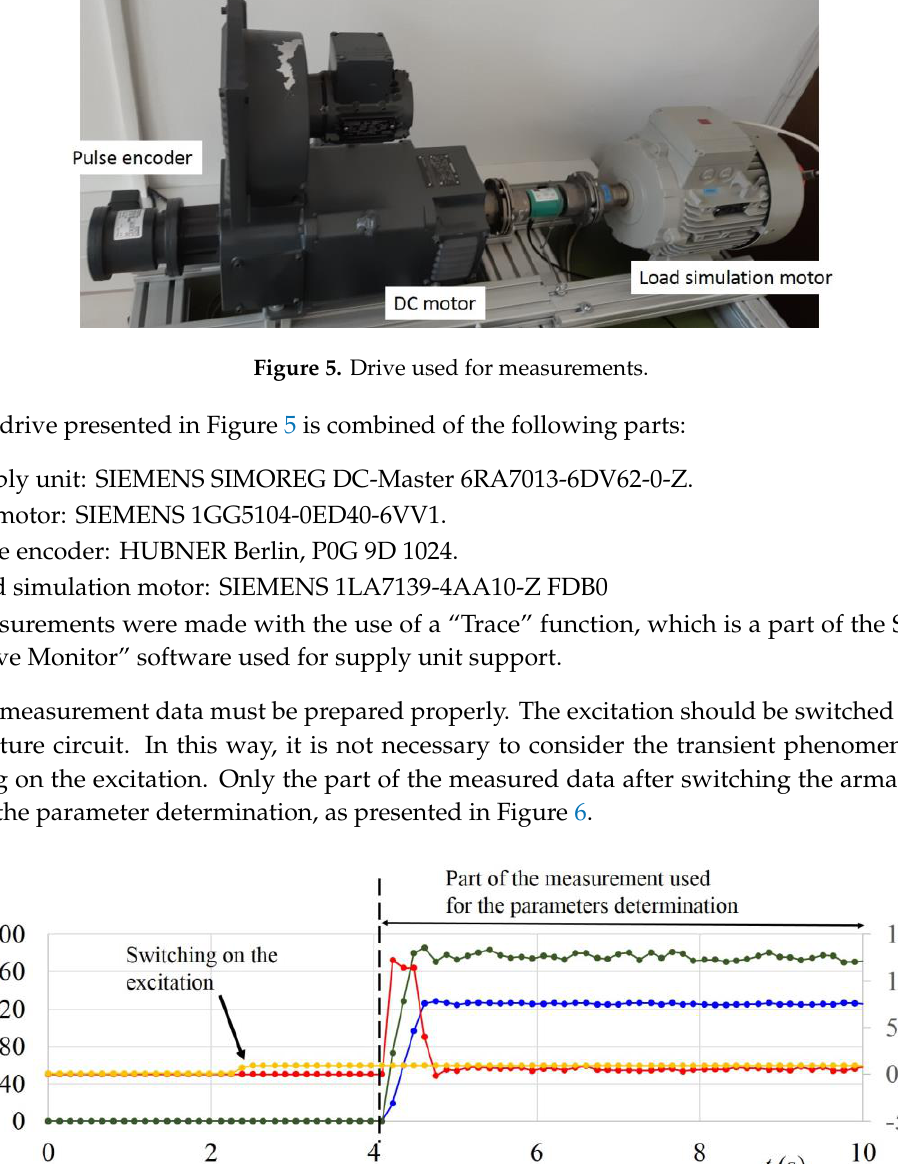
Table 7. Values used to get measured data.